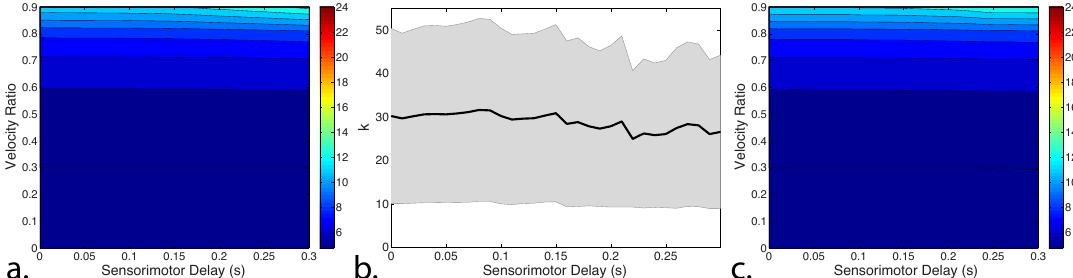
Figure 19. ( a ) The time to interception when varying the sensorimotor delay and the velocity ratio of a moving target using the constant bearing strategy. The P gain is optimised between 0.5 and 50 for each velocity ratio, and for various delays spanning the range (0, 0.3) s. The bar on the right provides a key for the time to interception (0, 24) s. All cases resulted in interception; ( b ) The effect of sensorimotor delay on P gain. The black line represents the mean P value over all velocity ratios for each sensorimotor delay. The grey shading represents the standard deviation around the mean P gain; ( c ) The time to interception when varying the sensorimotor delay and the velocity ratio of a moving target using the pursuit strategy. The mean P gain (see ( b )) for each delay is used. The bar on the right provides a key for the time to interception (0, 24) s. Reproduced with permission from